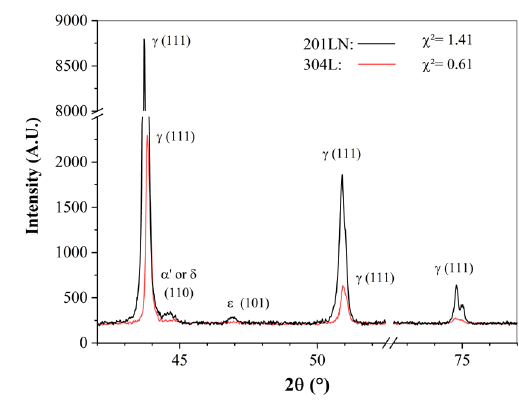
Figure 3. Diffractogram for 201LN and 304L steels in the as- received condition. Lower goodnessoffit ( 2 χ ) values were obtained by Rietveld method fitting in both cases.